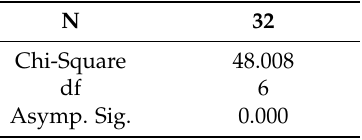
Table 10. Test statistics of Friedman test for prioritization of challenges of VIM application.